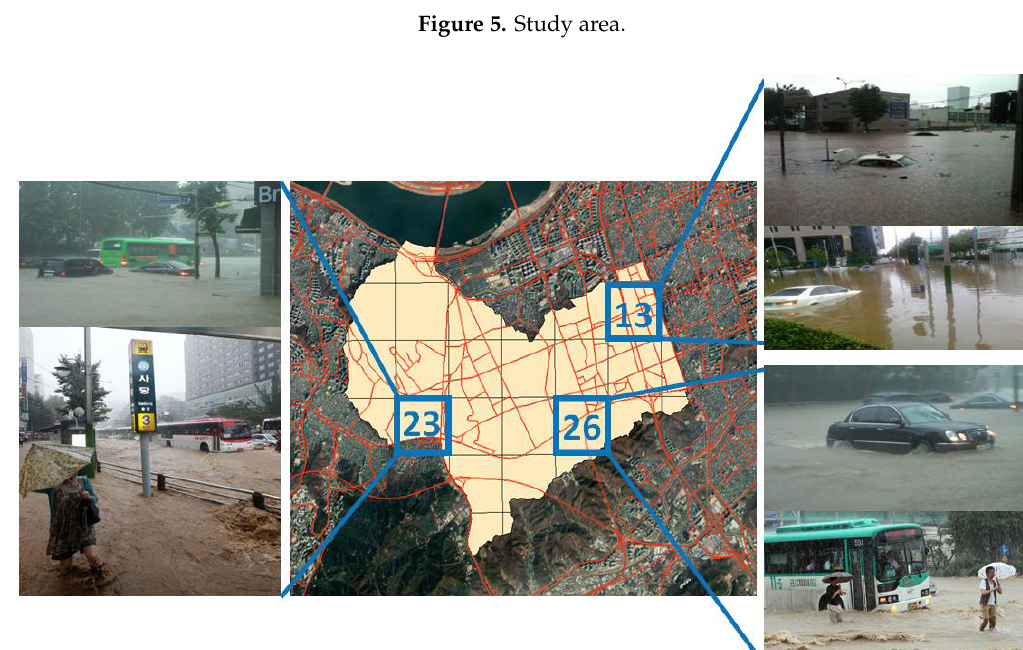
Figure 5. Study area.